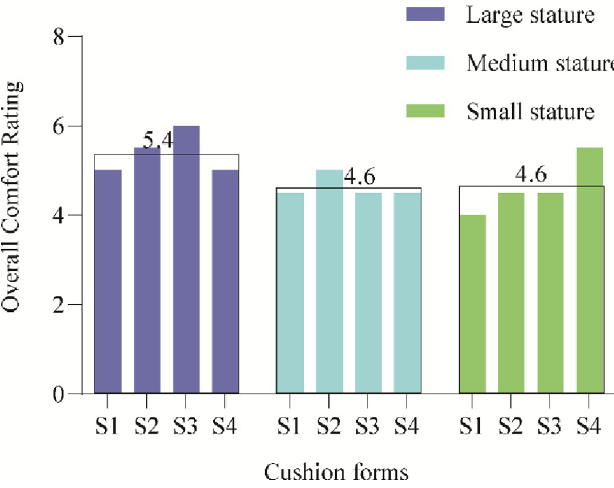
Fig 11. Histogram of average flat cushion comfort scores for three kinds of